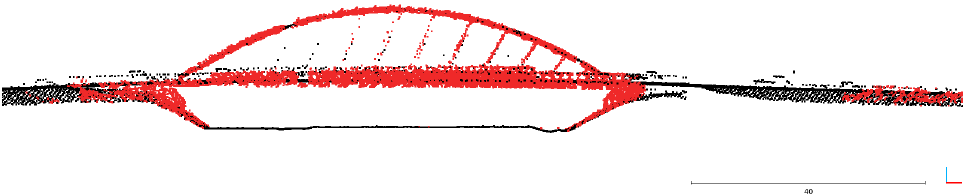
Figure 21. Cross section of scan obtained with designed system (red color) and DEM (black